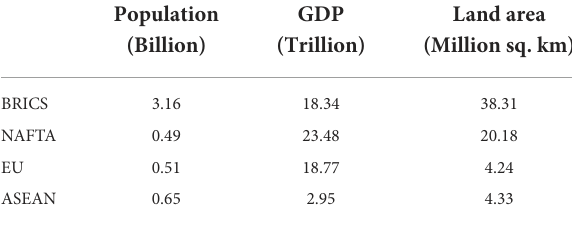
TABLE 1 Comparison between BRICS and major regional